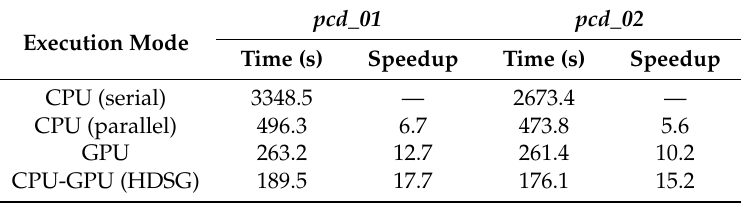
Table 6. Interpolation time (s) and speedups of different execution modes on hpc_02.